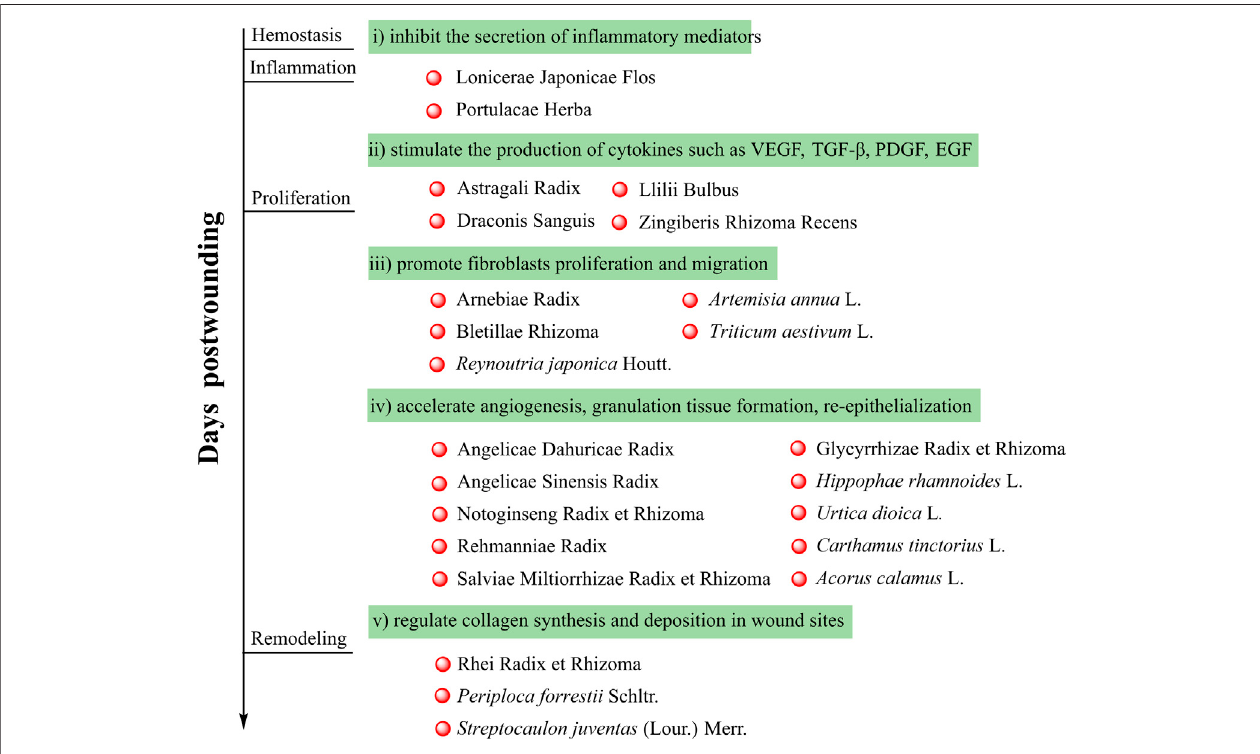
FIGURE 1 | Botanical drugs in traditional Chinese medicine and their wound healing